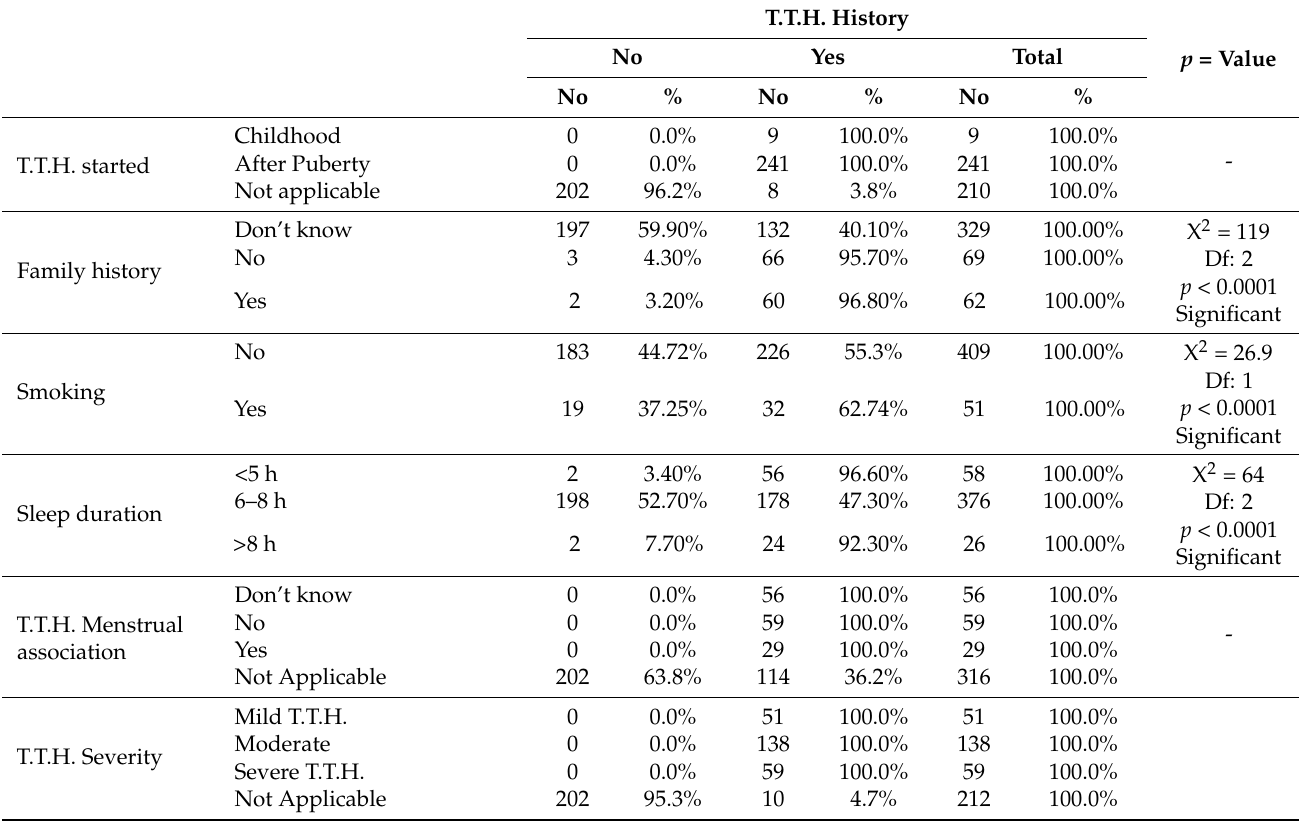
Table 4. Distribution of study subjects based on aggravating and relieving (triggers) factors vs. tension